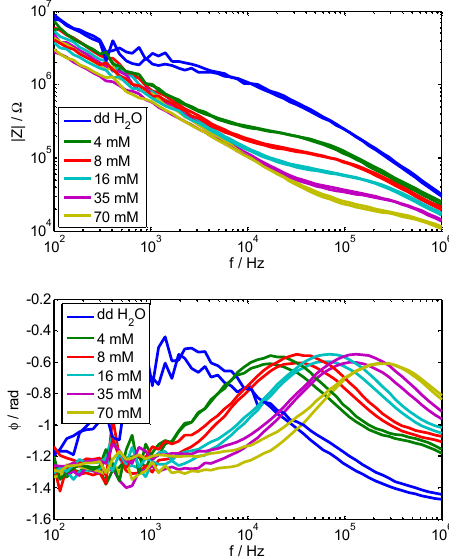
Fig.5: Magnitude and phase angle of a dilution series of PBS (phosphate buffered saline) without multiplexer. ddH 2 O (double distilled water) serves as low conductivity limit. For assessing the measurement and reference electrode, two measurements were necessary.